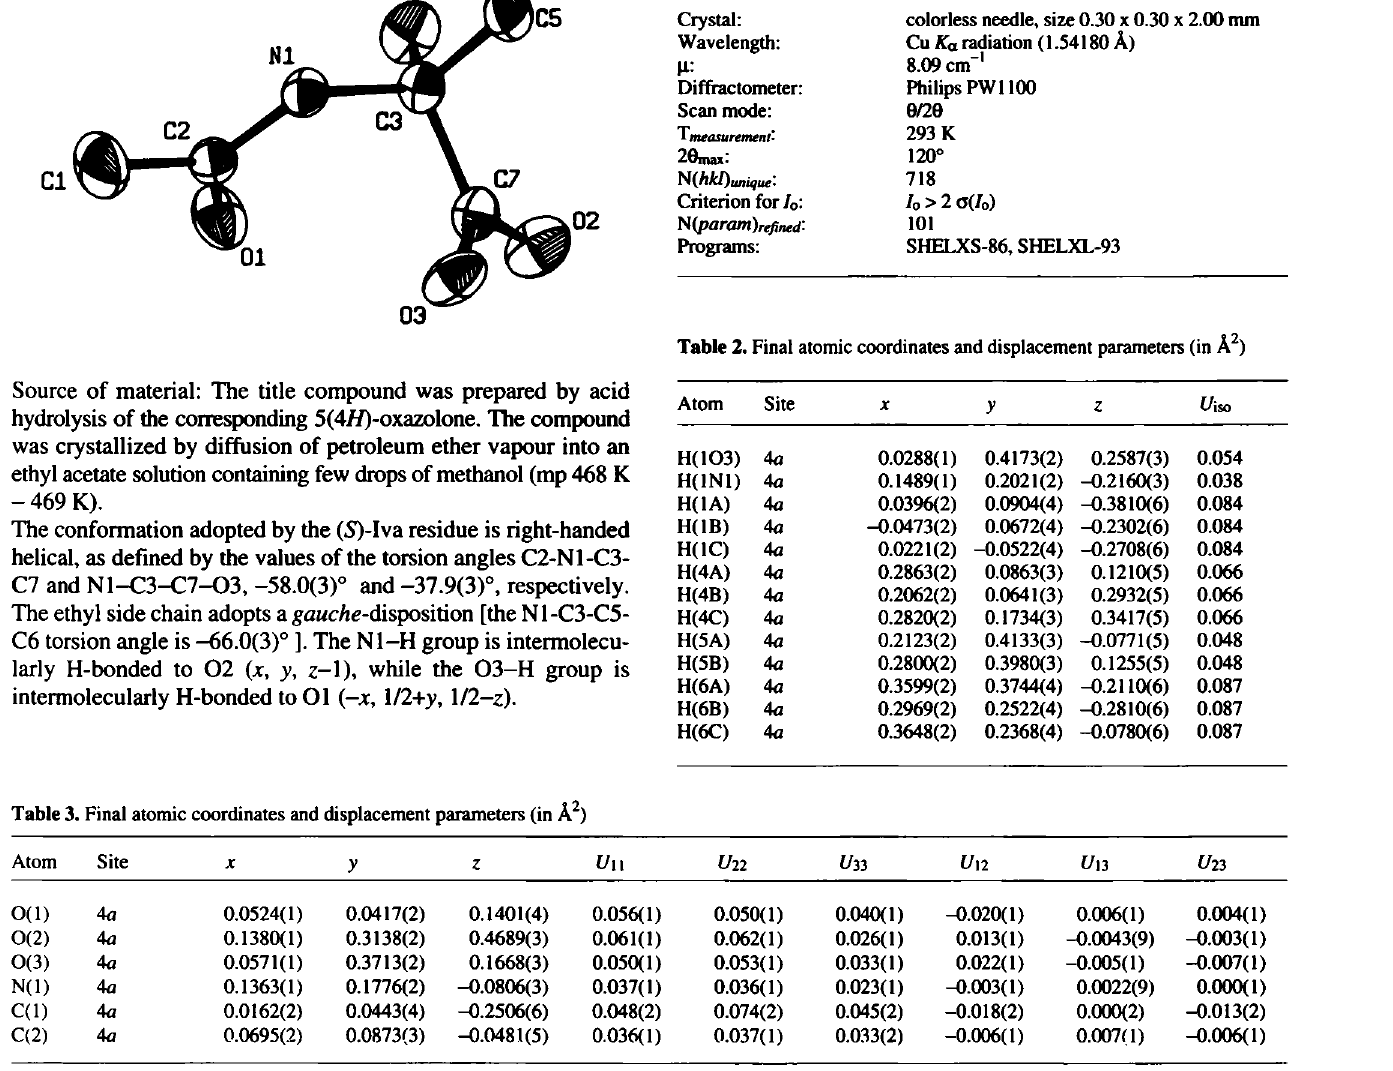
Table 1. Parameters used for the X-ray data collection Crystal;